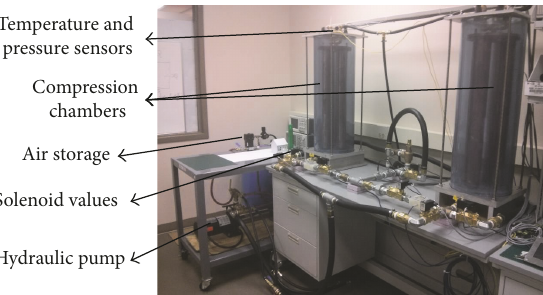
Figure 9: Experimental setup of liquid piston compressor.